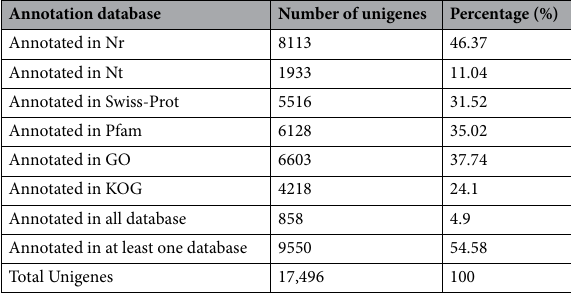
Table 2. Summary of functional annotation of unigenes of P. polysora .